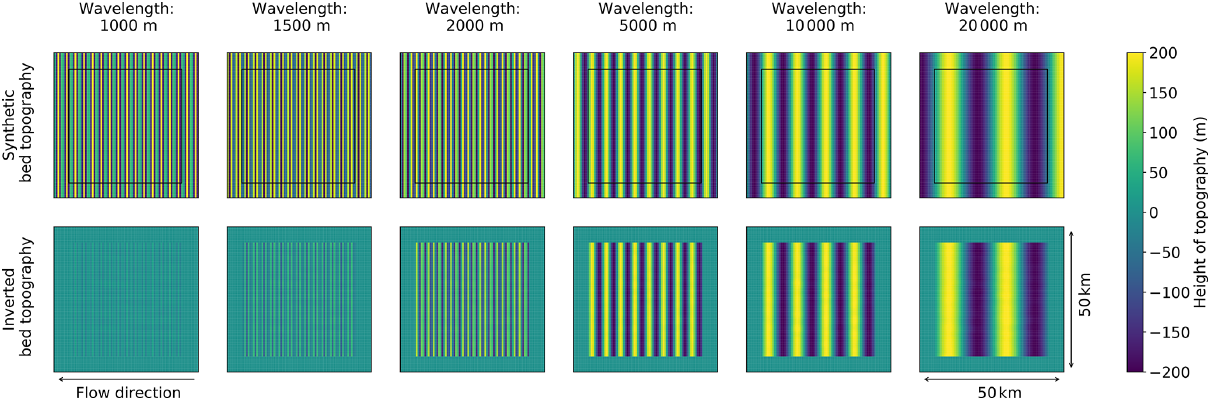
Figure 2. The effect of wavelength on how well landforms (top row; created synthetically) can be resolved by the inversion. These tests are presented on a 50km by 50km grid, where in the inversion results (bottom row) the outer 5km is greyed out to hide edge effects that will be neglected. In these simulations mean ice thickness h = 2000m, mean slipperiness C is 100, surface slope α is 0.02, amplitude is 200m and angle to flow θ is 90 ◦ . Landforms with a wavelength of less than 2km can not be well resolved due to the shallow-ice-stream